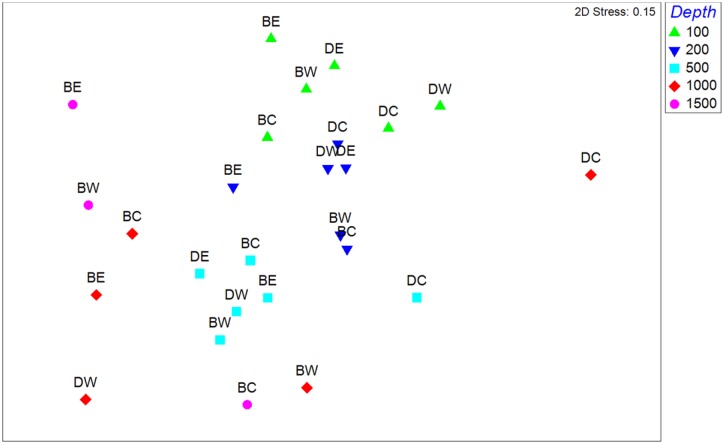
Unconstrained non-metric multidimensional scaling plot of station dissimilarities based on community composition.DC 1500 is not shown because its dissimilarity to other stations was so high that it prevented resolution of the relationships of the other stations. Station codes are as in Fig 2.